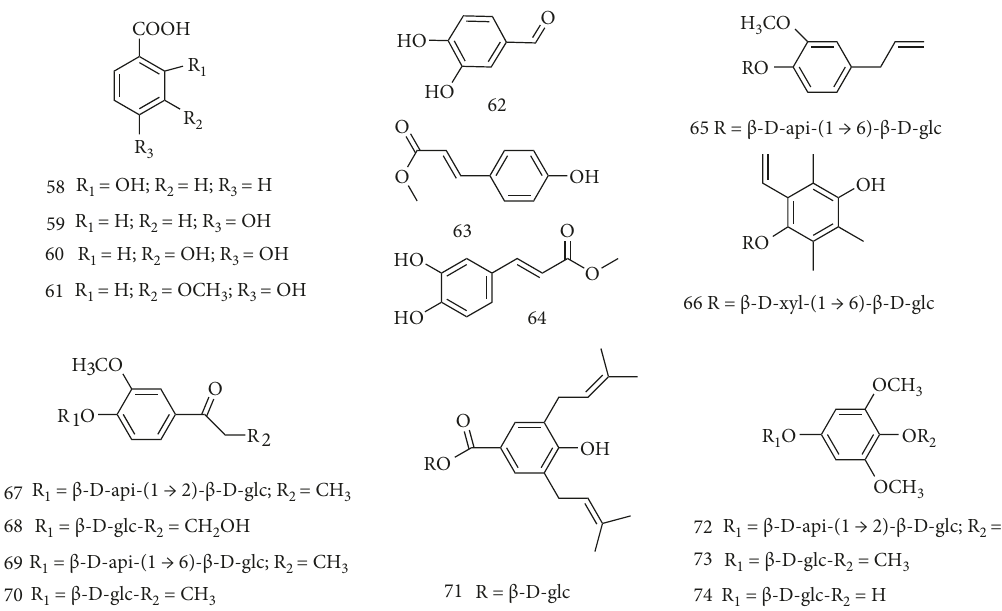
Figure 2: Structures of the phenolic acids and their derivatives found in F. tikoua Bur. Table 2: Phenolic glycosides isolated from F. tikoua